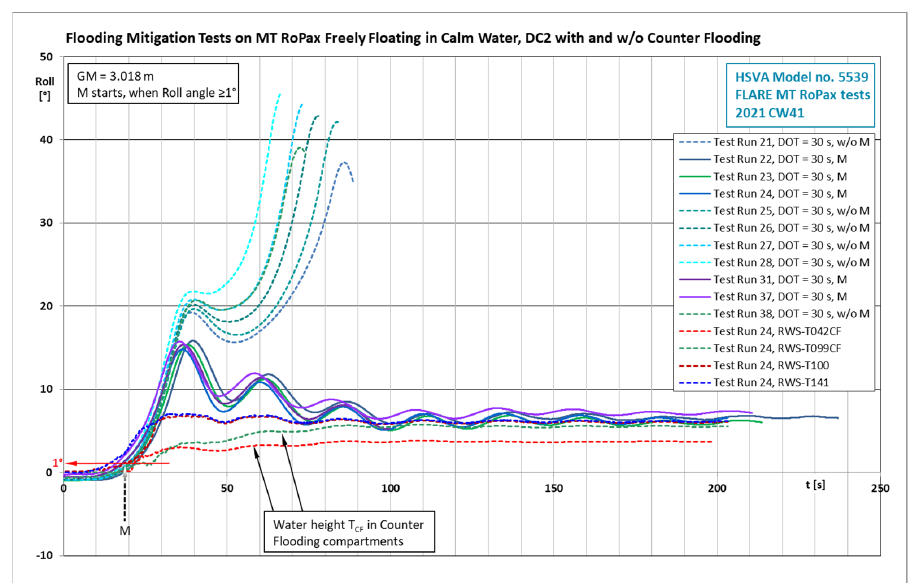
Figure 8. Damage Case 2 with damage opening time 30 s: Roll angle as a function of time with (solid lines) and without (dashed lines) counter flooding. The dashed curves below show the water height in the damaged compartments T100 and T141 and also in those for counter flooding T042CF and T099CF for Test Run 24.